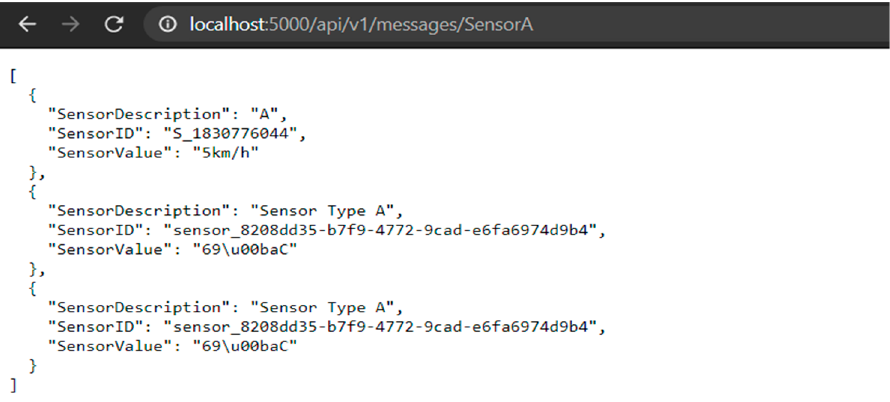
Figure 5. Call of an HTTP connector.